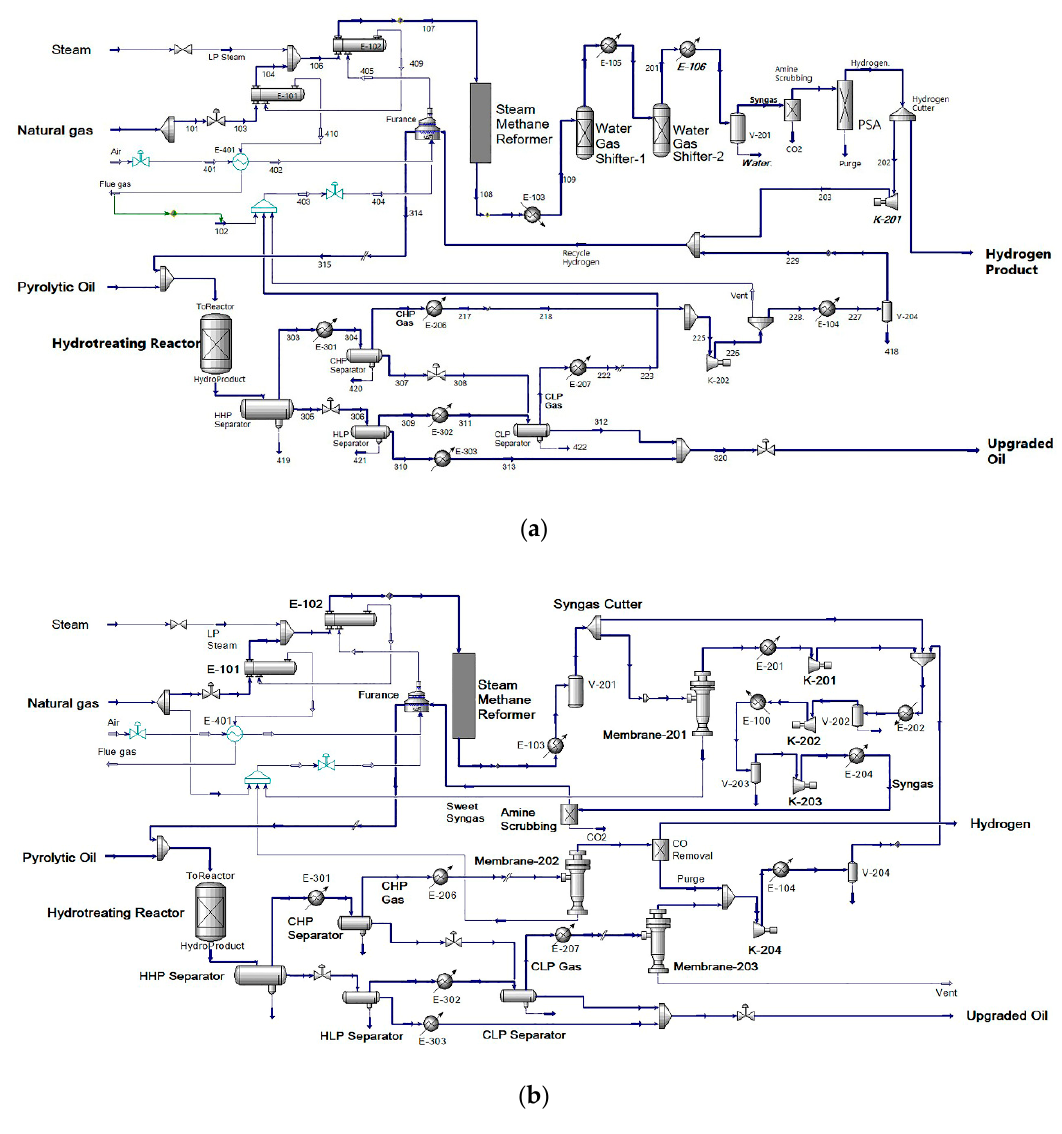
Figure 4. Process flow diagram of pyrolytic oil upgrading process. ( a ) Conventional process with a WGS reactor and PSA unit; ( b ) integrated steam methane reforming-hydrotreating process without a WGS reactor.